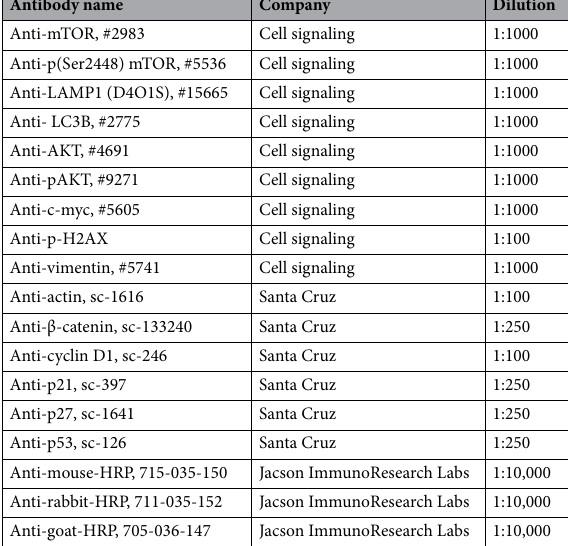
Table 2. List of antibodies used in Western